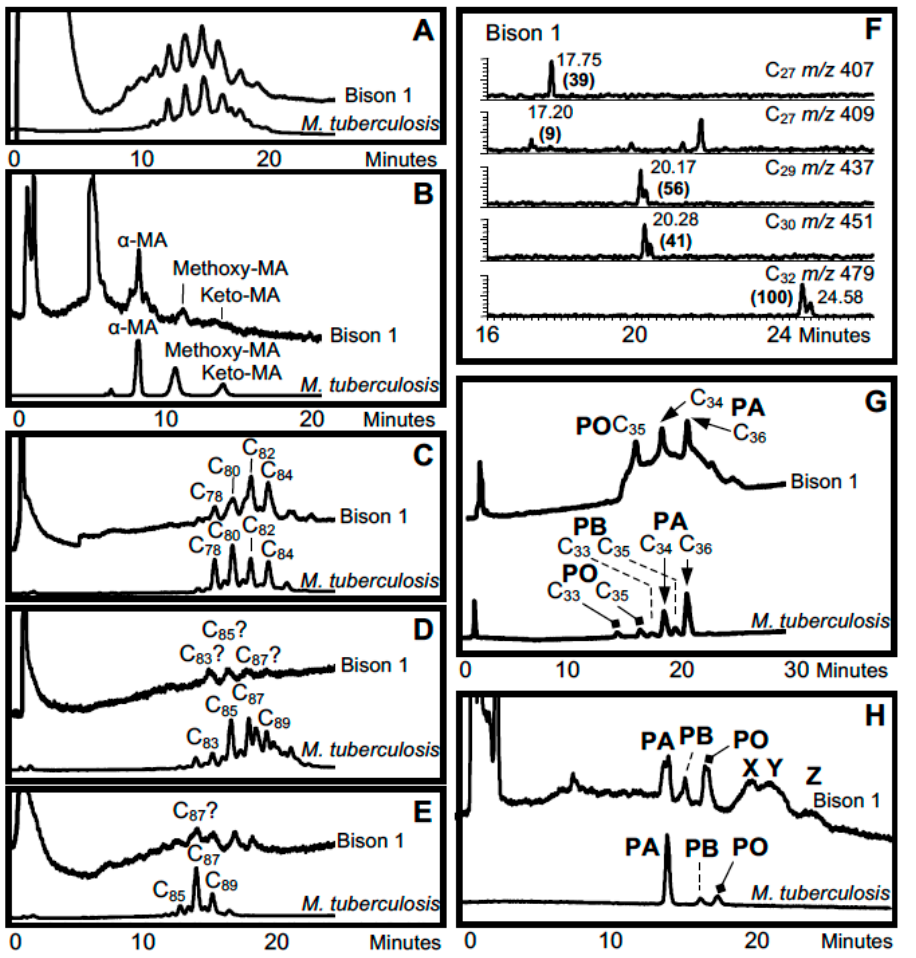
Figure 5. Lipid biomarker profiles for bison metacarpal from Natural Trap Cave with lesions [29,66]. ( A ) Total mycolates, reverse phase HPLC; ( B ) Collected total mycolates, normal phase; ( C )